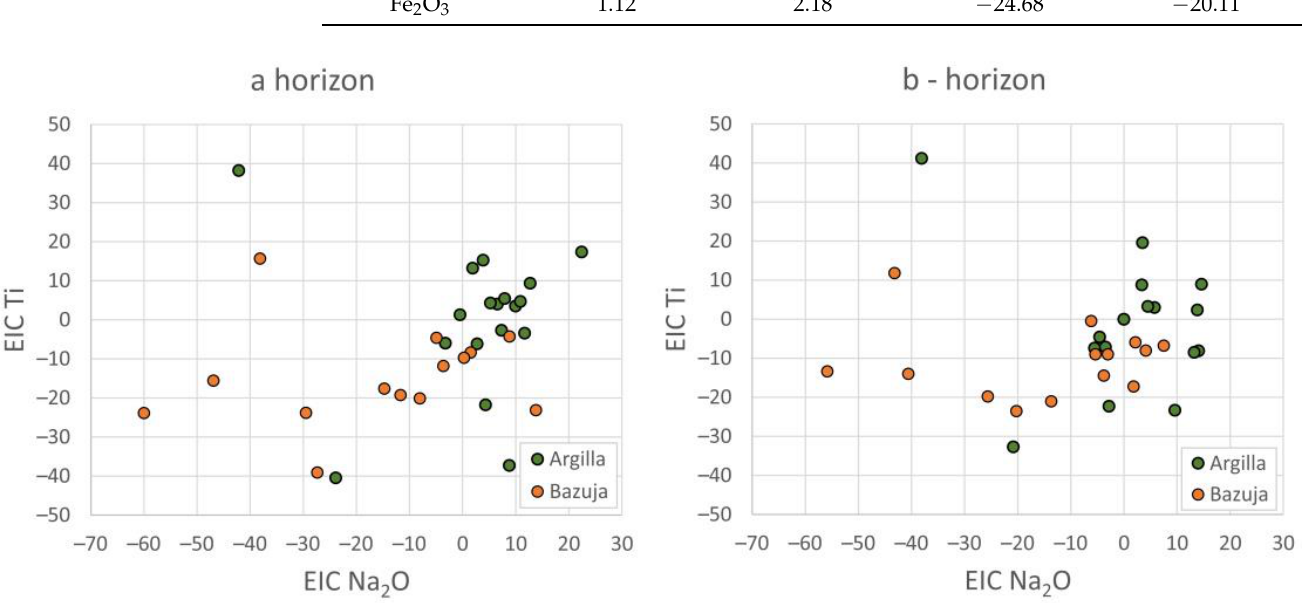
Figure 4. Distribution of calculated EIC Na 2 O compared with EIC Ti in ( a ) and ( b ) soil horizons in the rivers’ Argilla and Bazuja’s catchments.